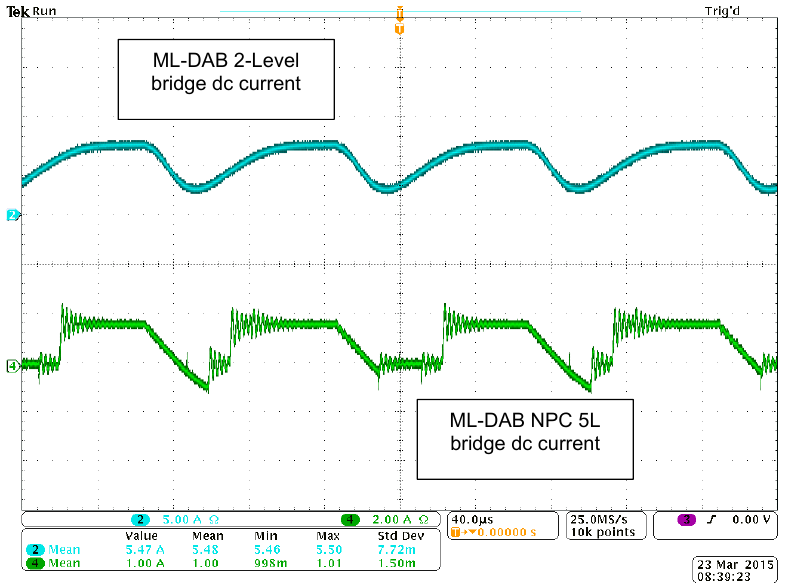
(cid:3031)(cid:3030) (cid:3118)(cid:3261)